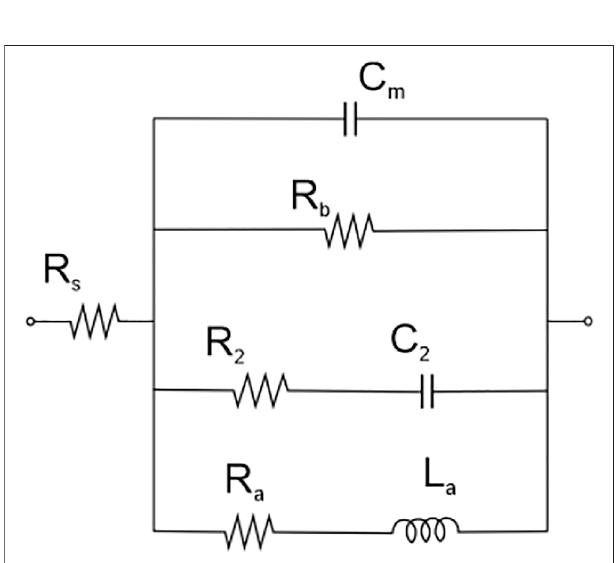
FIGURE12| Equivalentcircuitmodel.Theimpedancemodelisobtained by a small perturbation of Eqs. (1 , 2) . It has the expression (Berruet et al.,